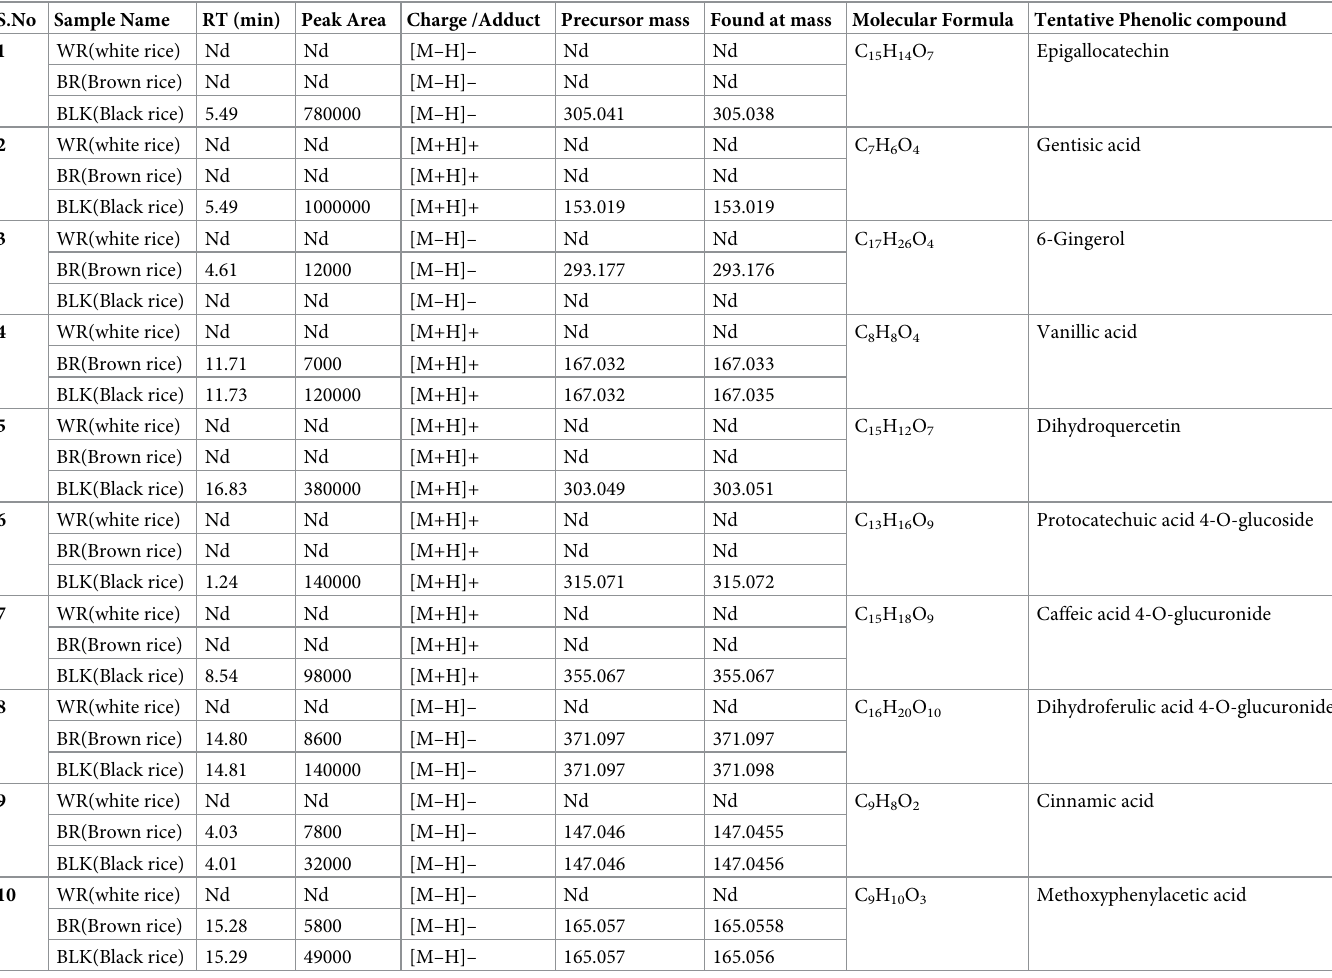
Table 3. Tentative phenolic phytochemicals discovered in the free fractions of white, brown and black rice by UHPLC-Q-TOF-MS 2